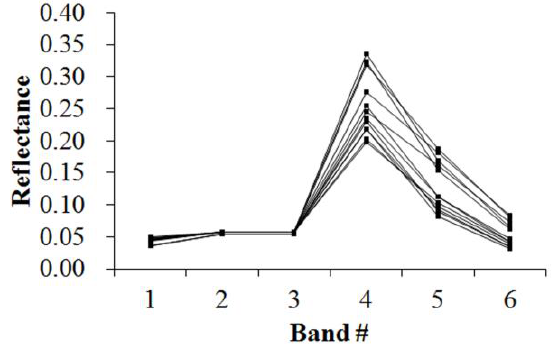
Figure 9. Spectral curves collected from samples used to determine Table 7. Table 7. Identification template 3 for forest class.